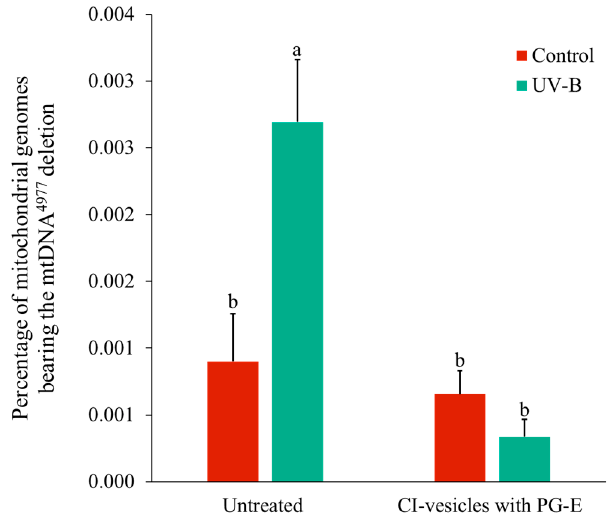
Figure 9. Amount of the “common deletion” 4977 in mitochondrial DNA (mtDNA 4977 ) in HaCaT cells exposed to UV radiation without prior treatment or treated for 24 h with cauliflower inflorescence vesicles (CI-vesicles) with pomegranate extract (PG-E) (0.01%) before radiation exposure. Data are means ± SE ( n = 3). Different letters indicate significant differences ( p < 0.05).